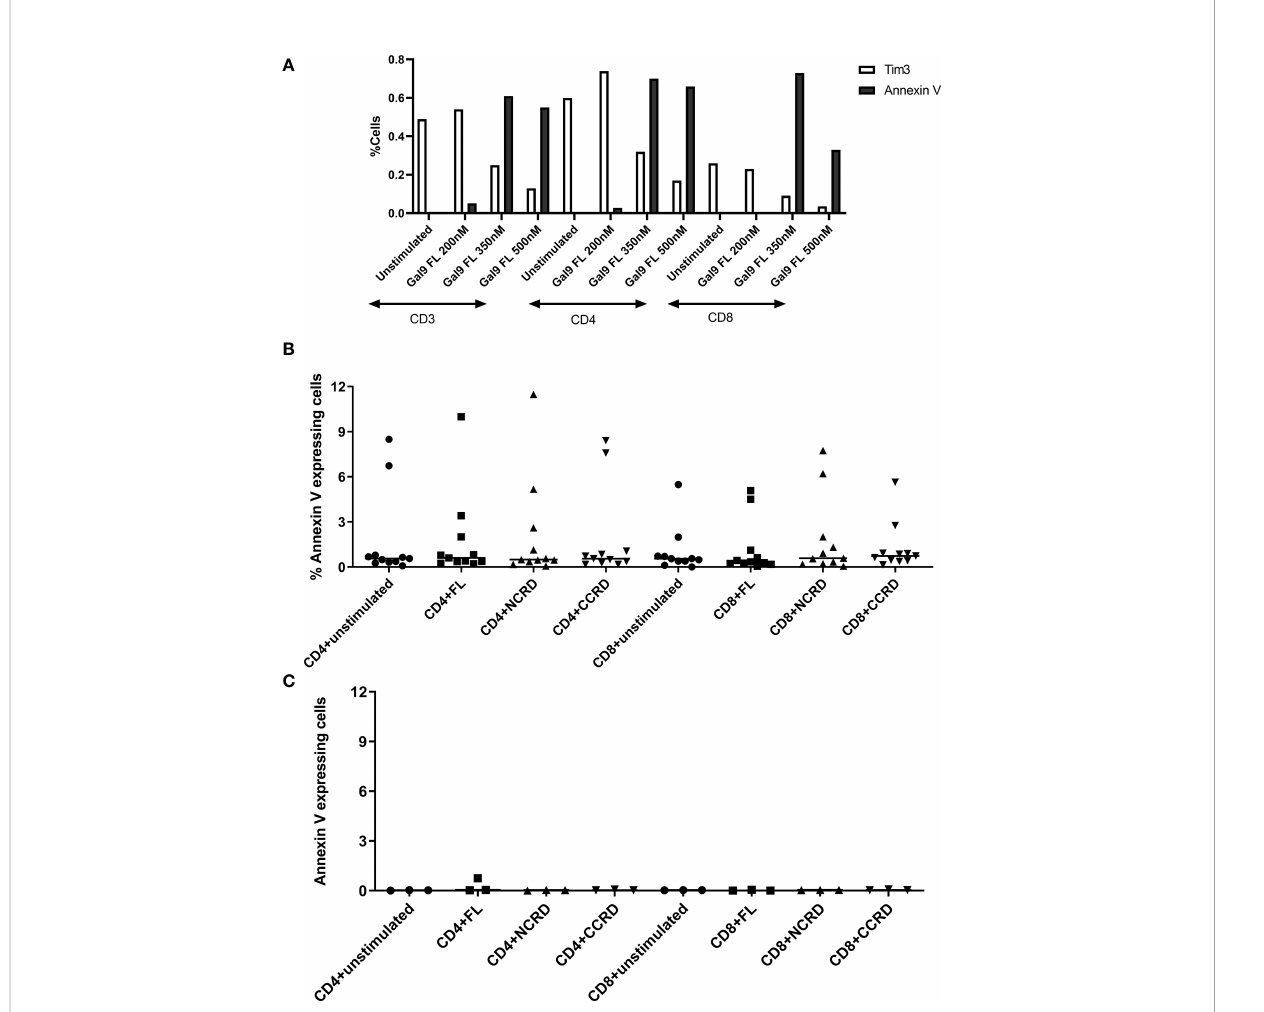
FIGURE 1 Expression of Annexin V and Tim-3 at different concentrations of the full-length and individual CRDs measured by fl ow cytometry assay. (A) CD3, CD4, and CD8 cells expressing Annexin V and Tim-3 after stimulation of peripheral blood mononuclear cells (PBMCs) with 200, 350, and 500 nM of full length Gal-9. (B, C) Percentage of CD4 and CD8 cells expressing Annexin V when PBMCs were stimulated with 350 nM concentration of all three fractions for 24 [ (B) , n = 11] and 48 [ (C) , n = 3] h. Individual values are plotted as scatter plots, and the horizontal line represents median